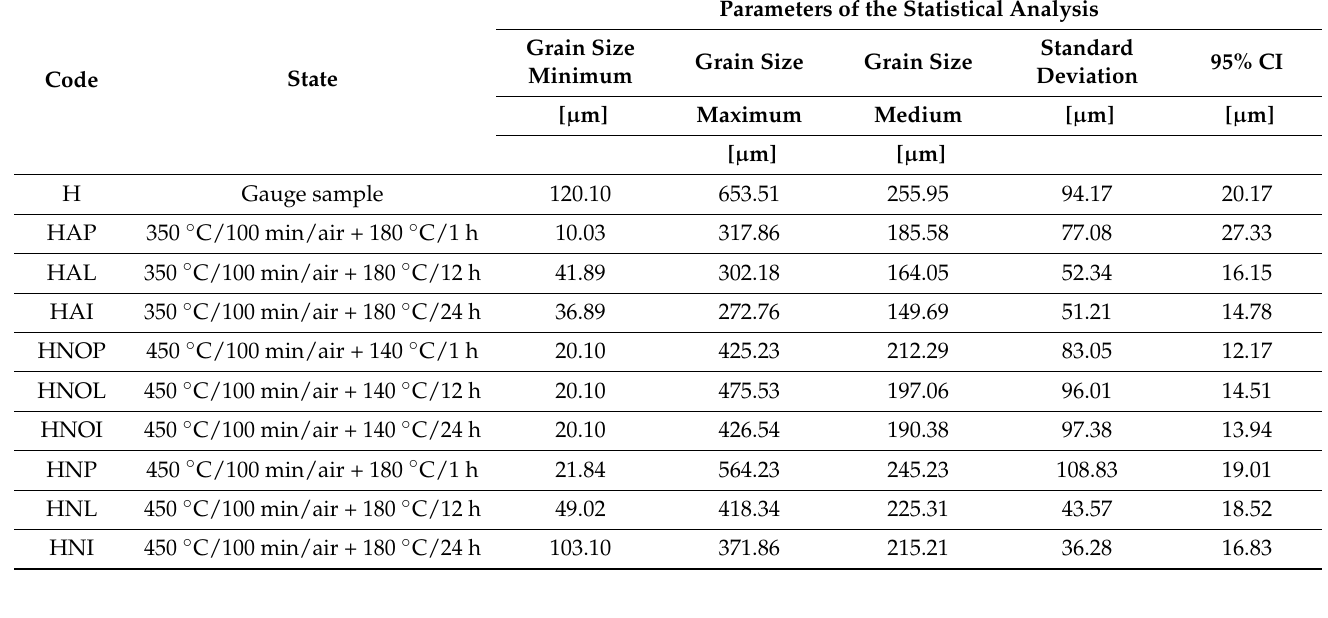
Figure 6. Structural analysis of cast experimental samples from aluminum 5083 alloy: ( a ) Gauge sample (H), ( b – d ) cast + quenched at 350 ° C/100 min/air + artificial ageing at 180 ° C; ( e – g ) cast + quenched at 450 ° C/100 min/air + artificial ageing at 140 ° C; ( h – j ) cast + quenched at 450 ° C/100 min/air + artificial ageing at 140 ° C ( b , e , h ) 1 h maintaining, ( c , f , i ) 12 h maintaining, ( d , g , j ) 24 h main- Table 3. Grain size analysis of the experimental alloy type 5083. taining . Table 3. Grain size analysis of the experimental alloy type 5083.